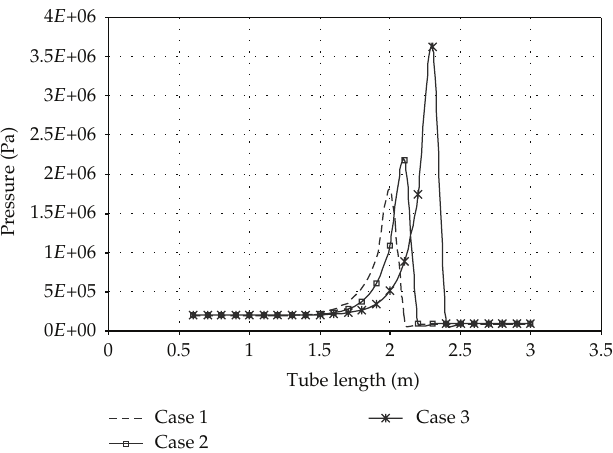
Figure 4: Pressure evolution along shock tube and as function of hydrogen mass fraction in air (cid:2) case 1: 1.5%, case 2: 2.5%, case 3: 5% (cid:3) .